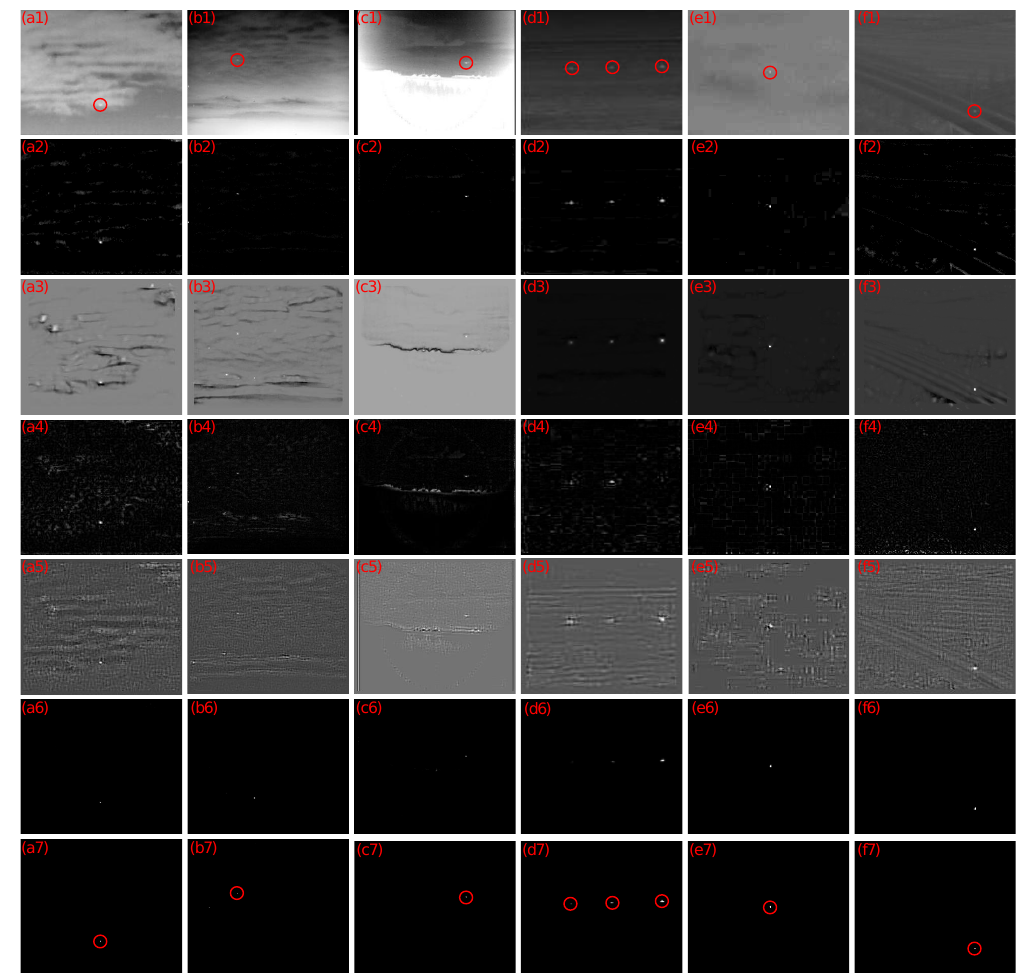
Figure 7. The output results of different methods on the test dataset: ( a1 – f1 ) the raw infrared images randomly selected from the three sequences and Set R (specifically: ( a1 ) the 3rd frame of Seq 1; ( b1 ) the 248th frame of Seq 2, ( c1 ); the 57th frame of Seq 3; and ( d1 – f1 ) images from